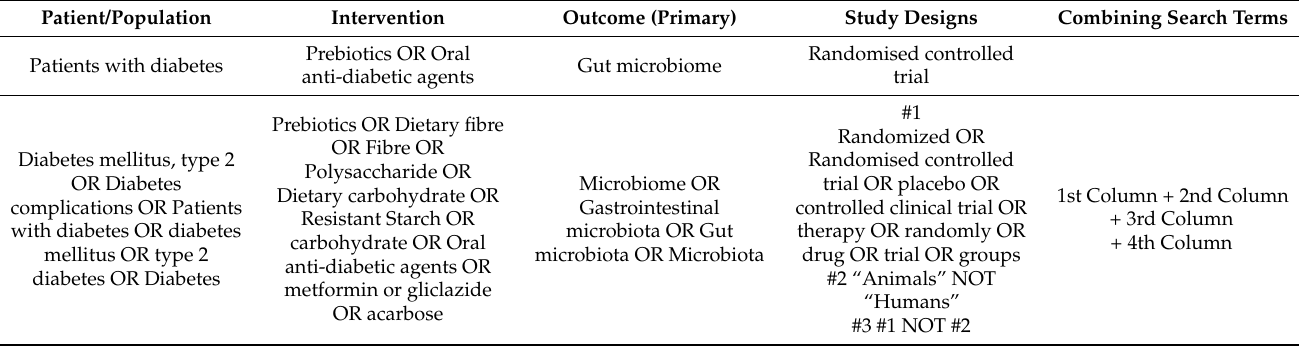
Table 1. Search Terms Based on PICOS